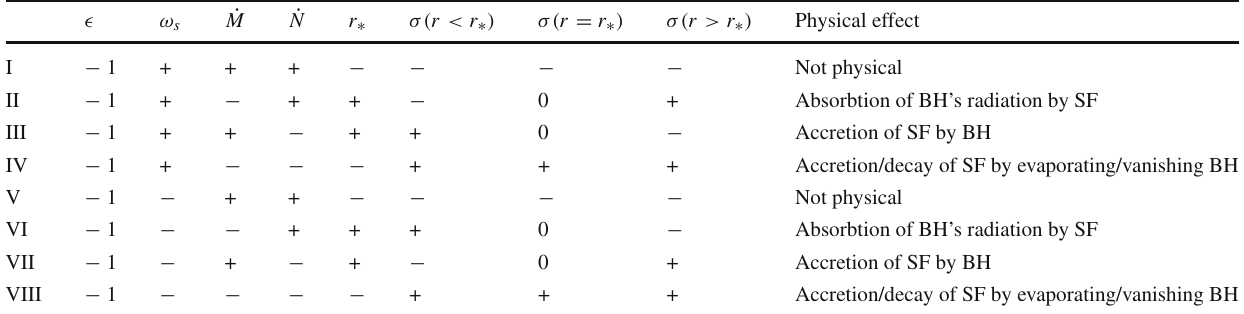
Table 1 General BH and SF parameters for (cid:5) = − 1